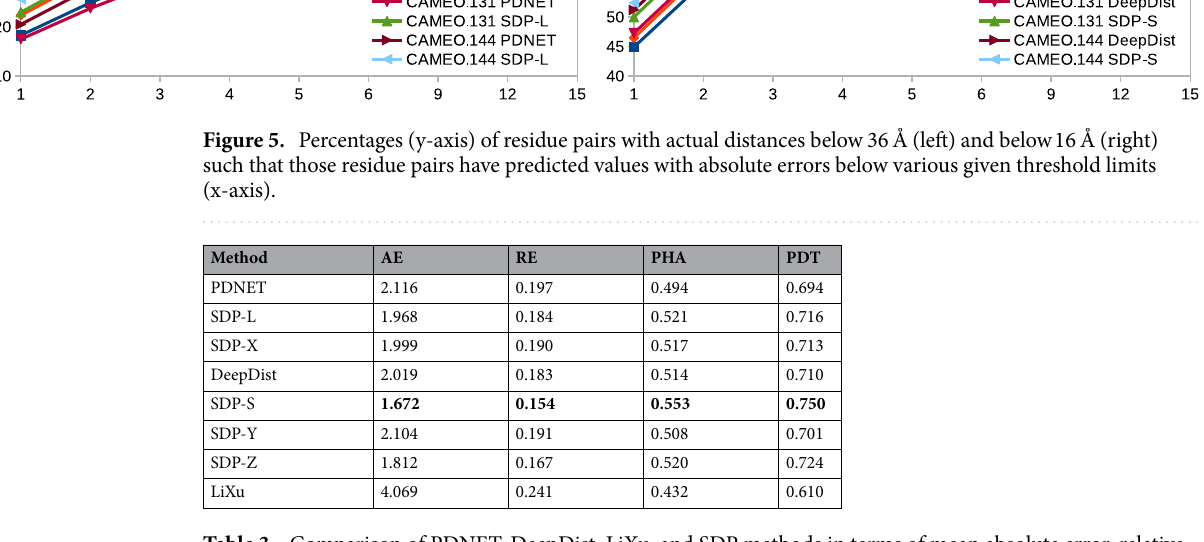
Table 3. Comparison of PDNET, DeepDist, LiXu, and SDP methods in terms of mean absolute error, relative error PHA and PDT scores over all residue paris in CASP13.31 dataset. The emboldened values denote the best performances; for AE and RE, the lower the better while for PHA and PDT, the higher the